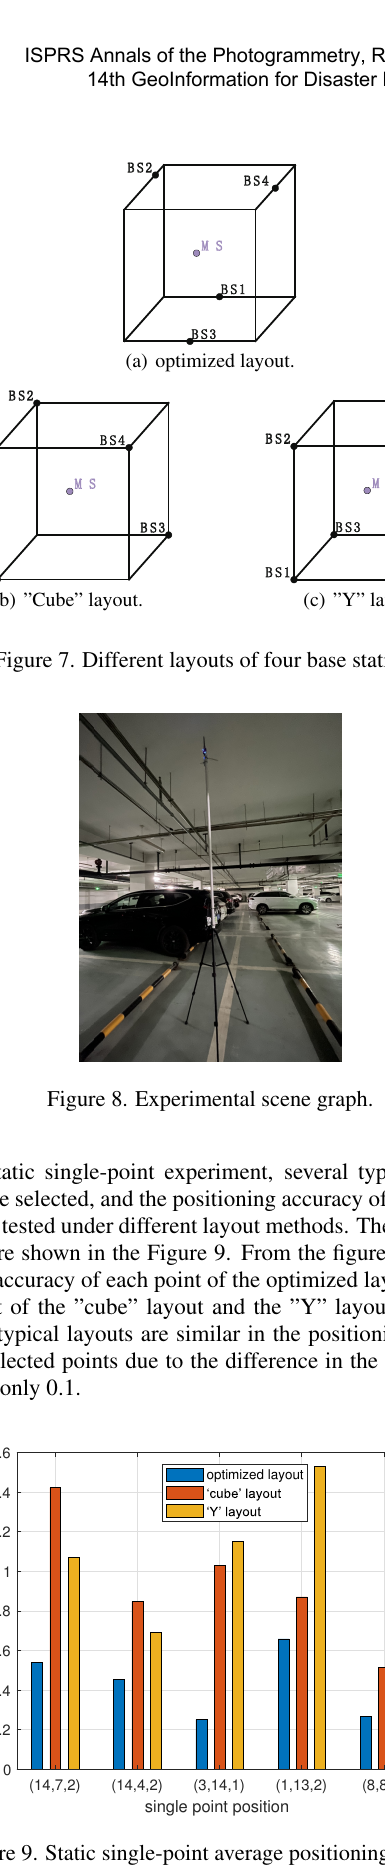
Figure 9. Static single-point average positioning error of different layout methods.